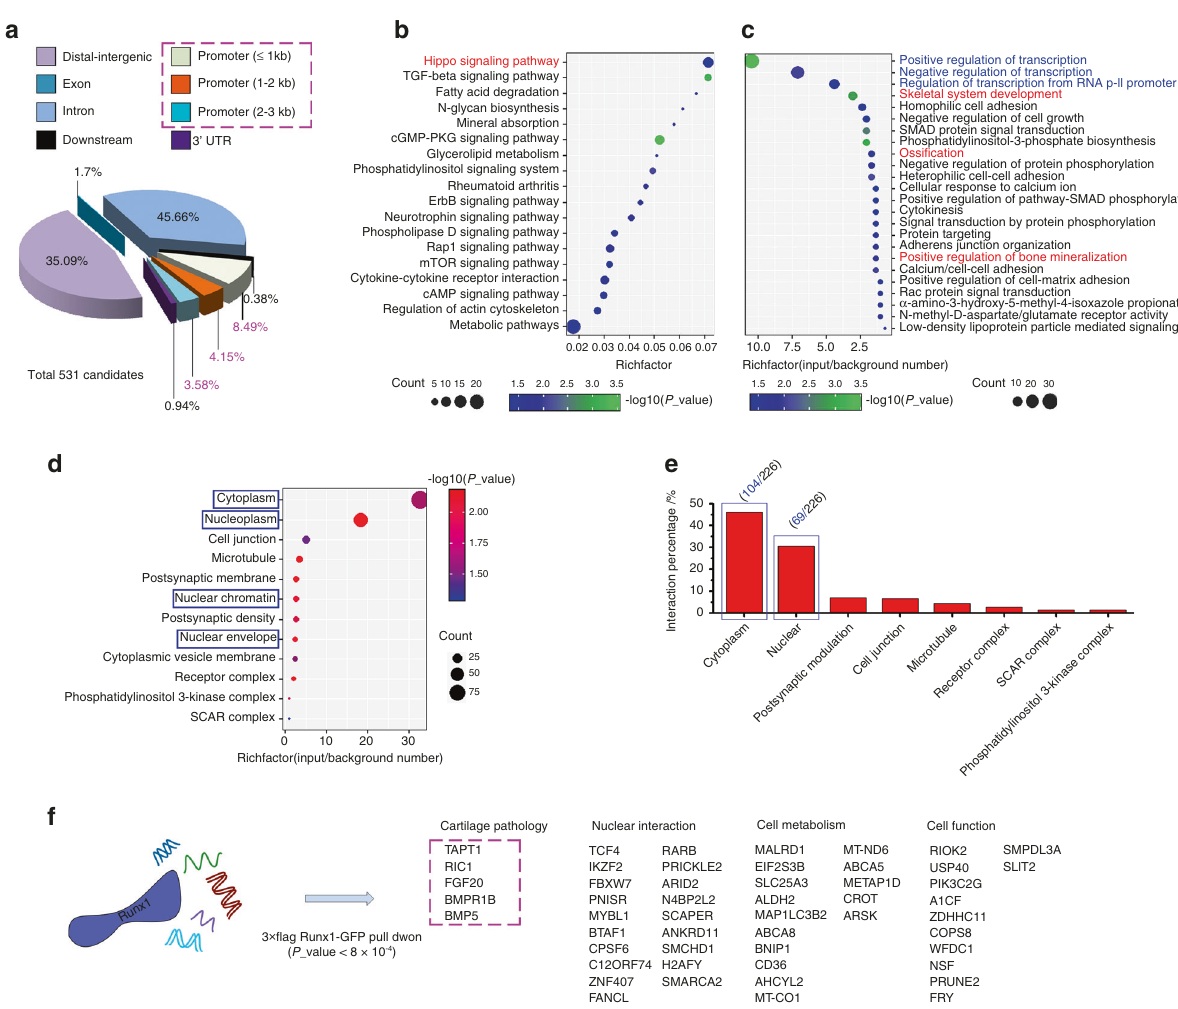
Fig. 5 ChIP sequencing identi fi ed the key target genes in cartilage pathology. a Pie chart showing the total classi fi cation of target DNA fragments pulled down by the 3× Flag-Runx1-GFP tag. b KEGG analysis showing that the DNA fragments in the promoter region ( ≤ 3 kb) were enriched in 18 pathways. c Biological process (BP) GO analysis showing that the targets that interact with Runx1 had high proportions in the cytoplasm and nucleus. Red processes show targets related to cartilage pathology. Blue processes show targets in the nucleus. d Cellular component (CC) GO analysis showing the distributions of targets among chondrocyte components. e The speci fi c proportions of targets that interact with Runx1 in chondrocytes. f Gene functional analysis indicating new targets that interact with Runx1 in chondrocytes in addition to the reported conventional binding TAPT1 (Fig. 7g), RIC1 (Fig. 7h), and FGF20 (Fig. 7i) in articular cartilage and the growth plate. Taken together, these results indicated that potential new pathogenic factors that interact with alleviation of joint destruction, articular cartilage damage, and Runx1 were identi fi ed. growth plate deterioration. ChIP sequencing was used to identify new target genes that interact with Runx1 during the process of OA. DISCUSSION In the current study, we used Col2a1-Cre mice instead of SOX9-Cre mice to delete Runx1 in chondrocytes to verify the speci fi c role of Runx1 in OA in adult mice. SOX9 plays a vital role in mesenchymal cell condensation and the initiation of progenitor cell differentia-